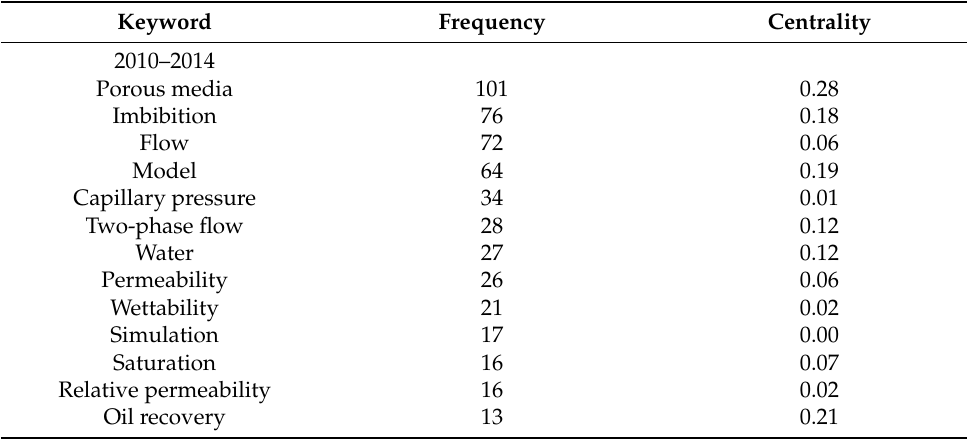
Figure 9. Timeline view of the keyword co-occurrence network. Table 1. Top 15 keywords related to imbibition, 2010 – 2014 and 2015 – 2020.